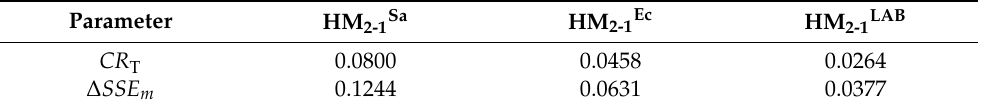
Table 5. Critical range of the SSE means and the differences between each pair of SSE means by comparing the one- and two-step